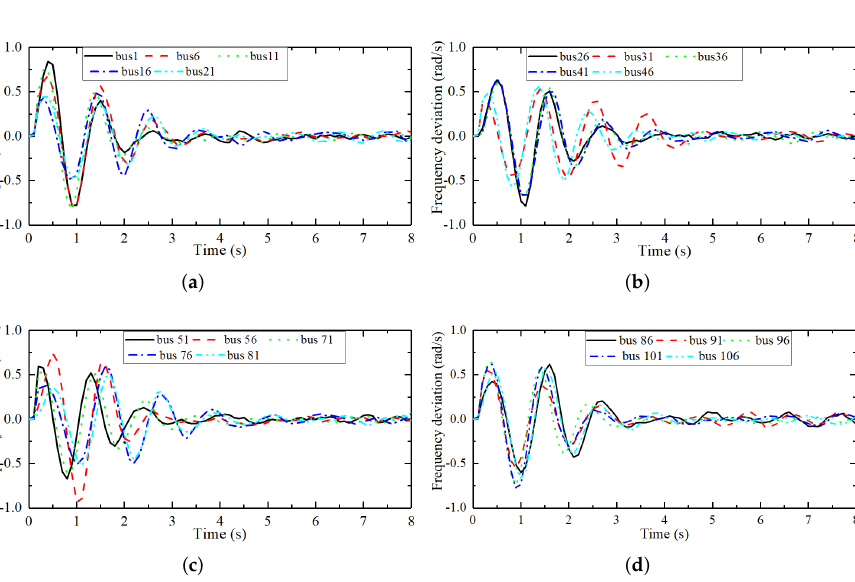
Figure 16. Frequency deviation curve of the IEEE118 bus testing system under the controller, η ji = 0.2. ( a ) Frequency deviation curves of bus 1, 6, 11, 16, and 21. ( b ) Frequency deviation curves of bus 26, 31, 36, 41, and 46. ( c ) Frequency deviation curves of bus 51, 56, 71, 76, and 81. ( d ) Frequency deviation curves of bus 86, 91, 96, 101, and